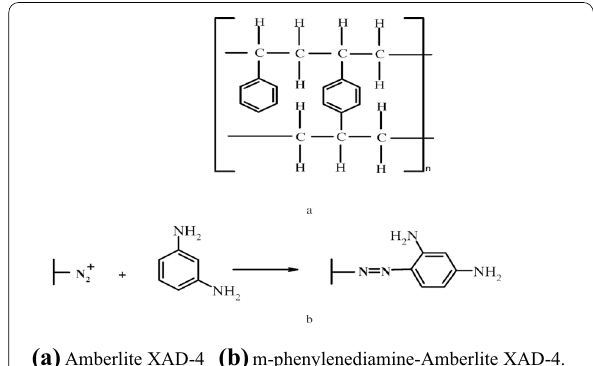
Fig. 1 a Amberlite XAD-4 and b m-phenylenediamine Amberlite